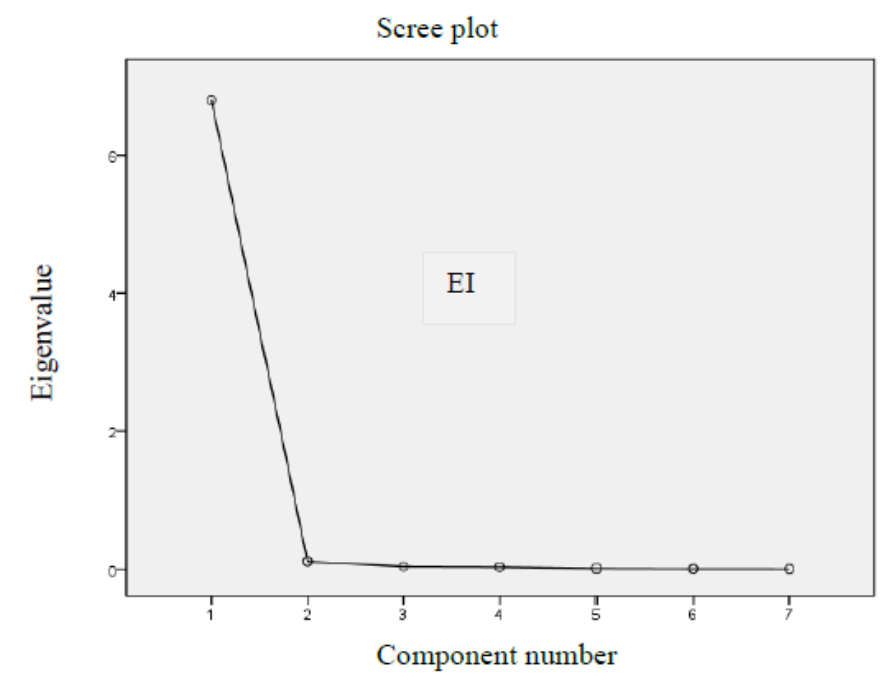
Figure 2. Scree plot for the EI. Source: authors’ own compilation. Table 9. Eigenvalues of factors and the percentage of the sum of the variance explained for the EI. Component Eigenvalue % of Variance The eigenvalues of the factors and the percentage of the sum of the variance ex- plained were also specified (Table 9).